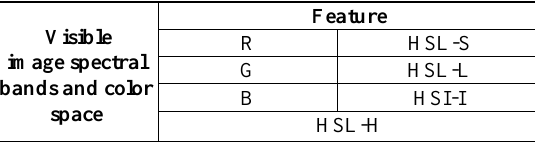
Table 2. Features extracted from visible UAV